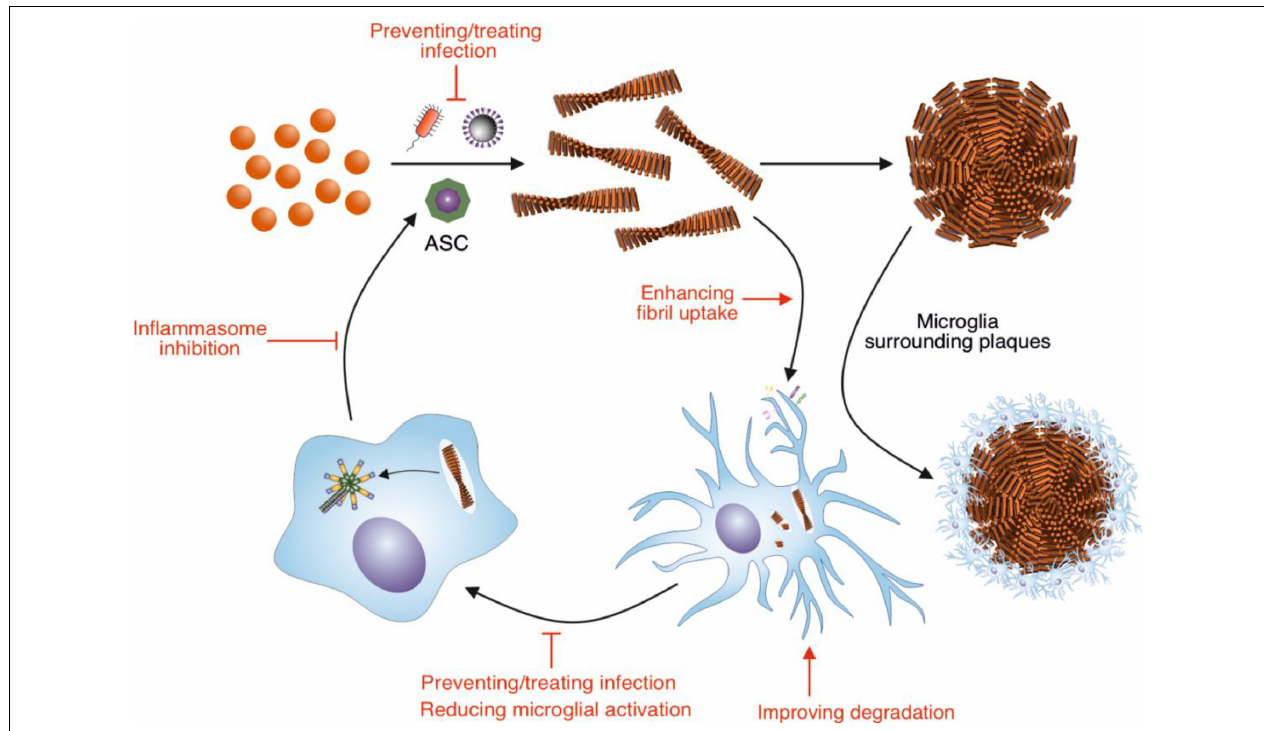
FIGURE 1 | Modulation of A β amyloid fibril assembly and clearance by microglial cells and infection, and potential targets of intervention. A β peptide assembles into highly ordered amyloid fibrils with a characteristic cross- β structure. These fibrils form the core of amyloid plaques present in AD brains. Microglia surround these plaques, forming a protective barrier around them, limiting the recruitment of further A β . Microglia can also contribute to the clearance of A β fibrils. In order to remove A β deposits in AD, the phagocytic activity of microglia could be enhanced by targeting receptors and pathways involved in this response, such as TREM2 and CD33. Increasing the breakdown by microglial proteases could also enhance clearance of A β deposits. The NLRP3 inflammasome in microglia is concurrently activated in response to A β fibrils, resulting in the release of ASC specks. These specks cross-seed the formation of A β fibrils, resulting in further A β aggregation. Therefore, inhibiting the activation of the NLRP3 inflammasome would reduce the cross seeding of A β aggregation by ASC specks. A β also has antimicrobial and antiviral-properties, assembling into amyloid fibrils in response to infection. Thus, infection could be targeted to reduce A β